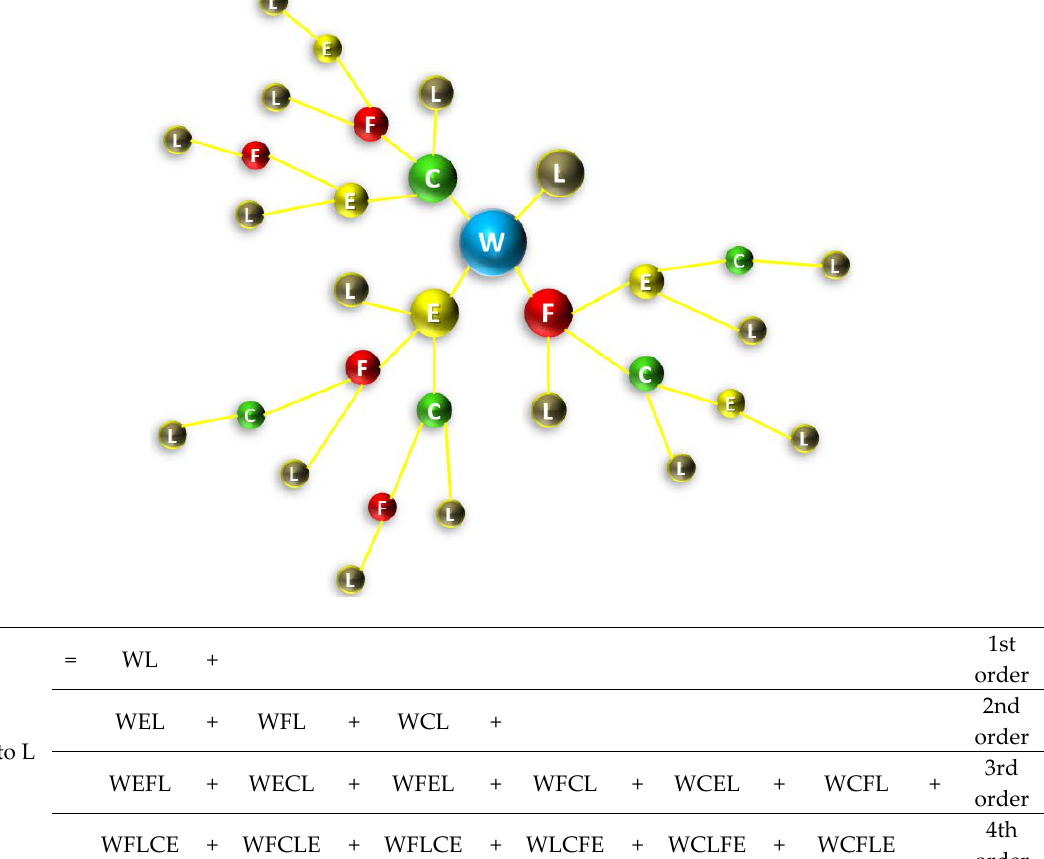
Figure 3. Nexus tree for Water to Land Use, showing the formation of all 16 direct and indirect pathways by which a change in Water can bring about a change in Land